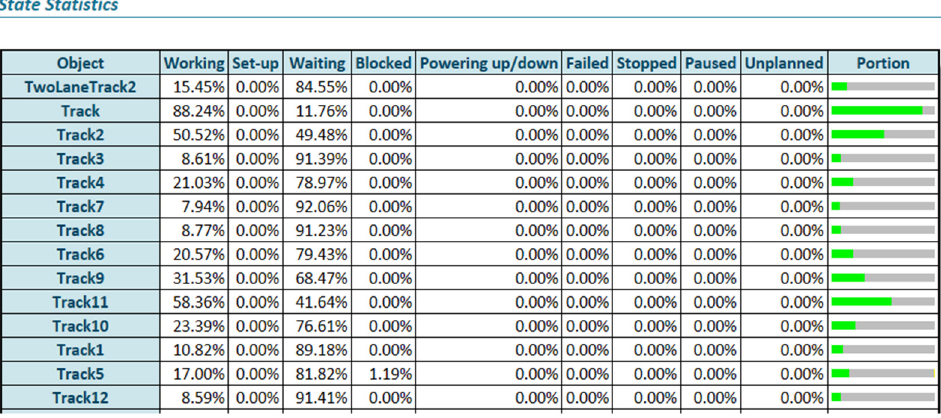
Figure 20. Presentation of the road capacity deployment in a simulation experiment.